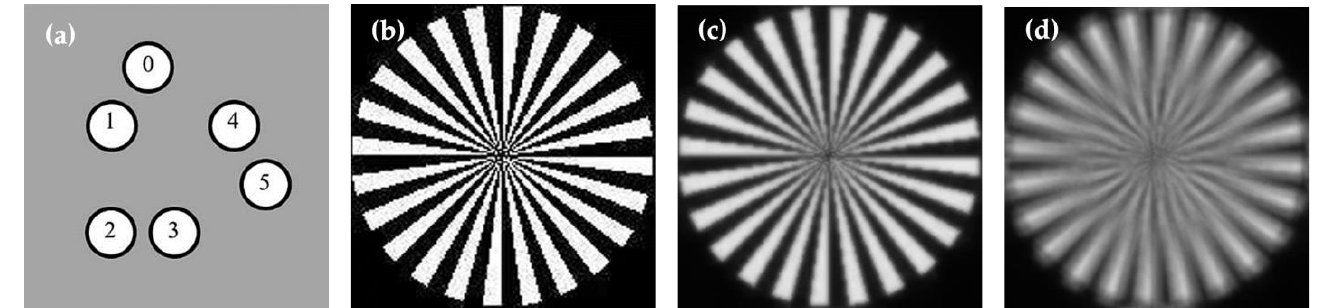
Figure 1. Golay-6 structure and its simulated imaging results: ( a ) configurations of Golay-6 arrays; ( b ) imaging target; ( c ) the simulated imaging map of Golay-6 system (focused image); ( d ) the defocused imaging map.